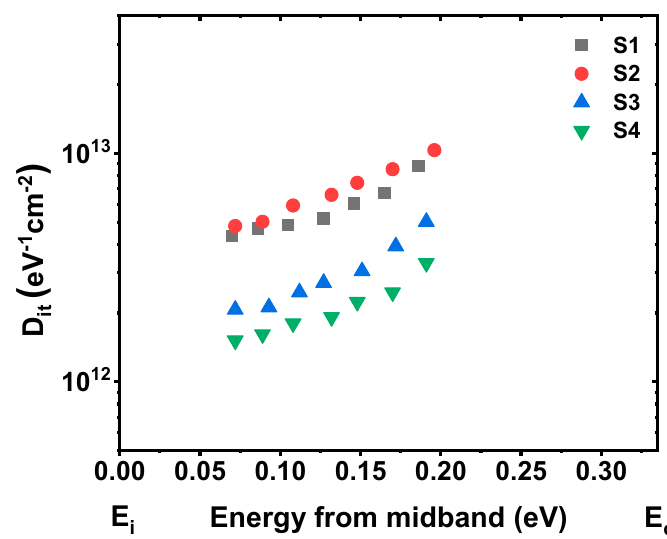
Figure 7. Multi-frequency C-V characteristics measured of the fabricated Al/HfO 2 /La 2 O 3 /Ge MIS capacitors with different ALD cycles of La 2 O 3 passivation layer. ( a ) The control sample; ( b ) 5 ALD cycles of La 2 O 3 passivation layer; ( c ) 10 ALD cycles of La 2 O 3 passivation layer; and ( d ) 15 ALD cycles of La 2 O 3 passivation layer.